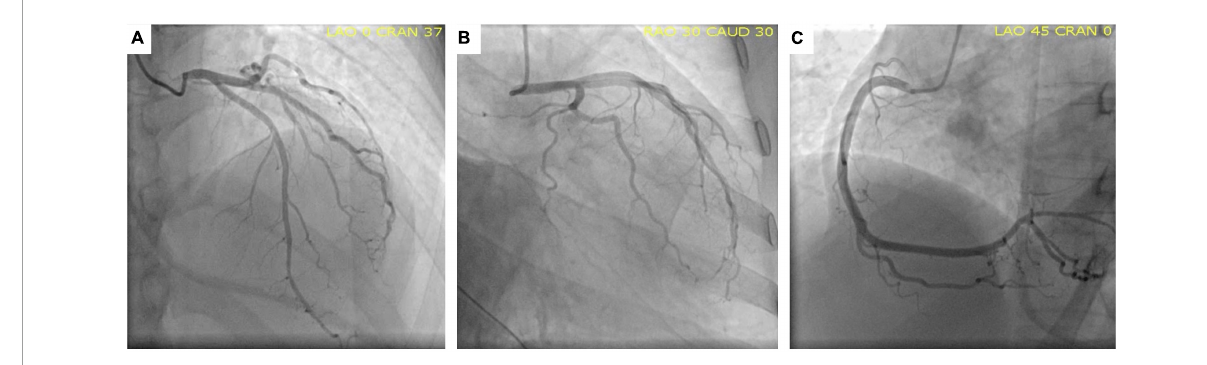
FIGURE2 Normal coronary angiography. Anterior-posterior cranial view (A) , Caudal left-anterior-oblique view (B) and Left-anterior-oblique view (C) showing the circumflex artery, left anterior descending artery, and right coronary artery, respectively, without lesions.